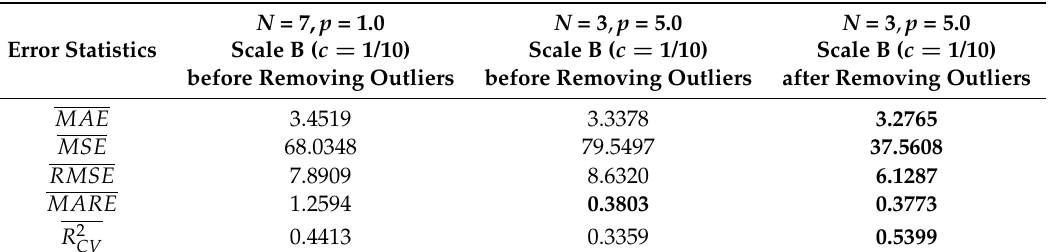
Table 5. Error statistics comparison of two configurations under Scale B using the IDW-based extension method and 10-fold cross